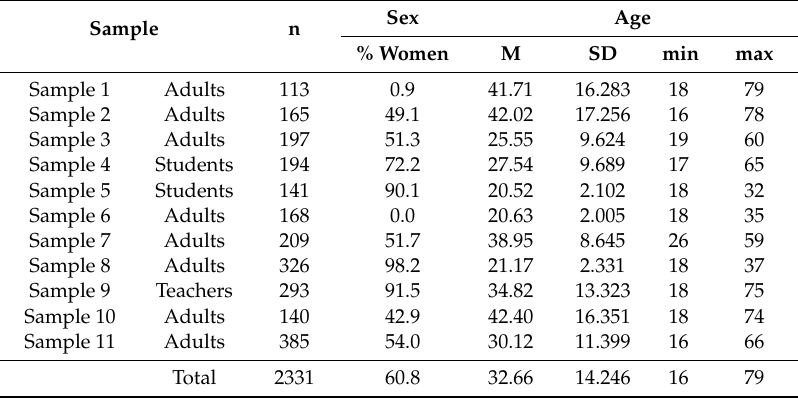
Table 4. The characteristic of the